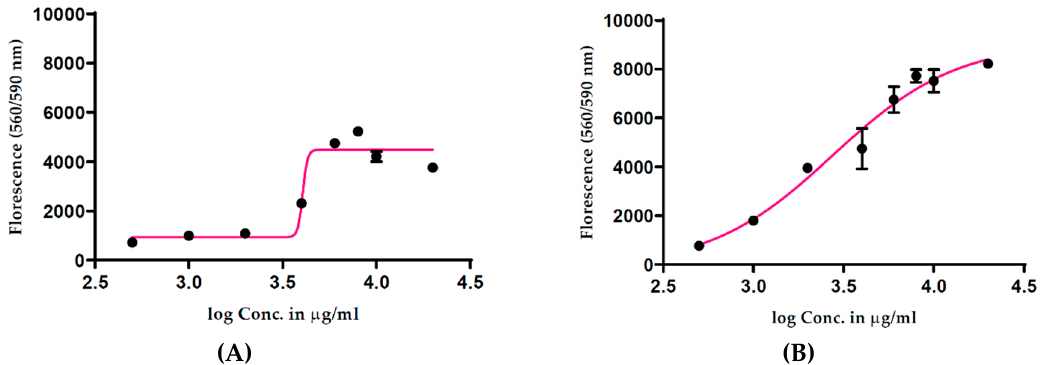
Figure 2. Effect of T. ferdinandiana methanolic ( A ) and water ( B ) extracts of fruits in a cell-free system using the CellTiter-Blue ® Cell Viability Assay. All concentrations were tested in triplicate with mean values ± SEM used to construct dose–response curves.